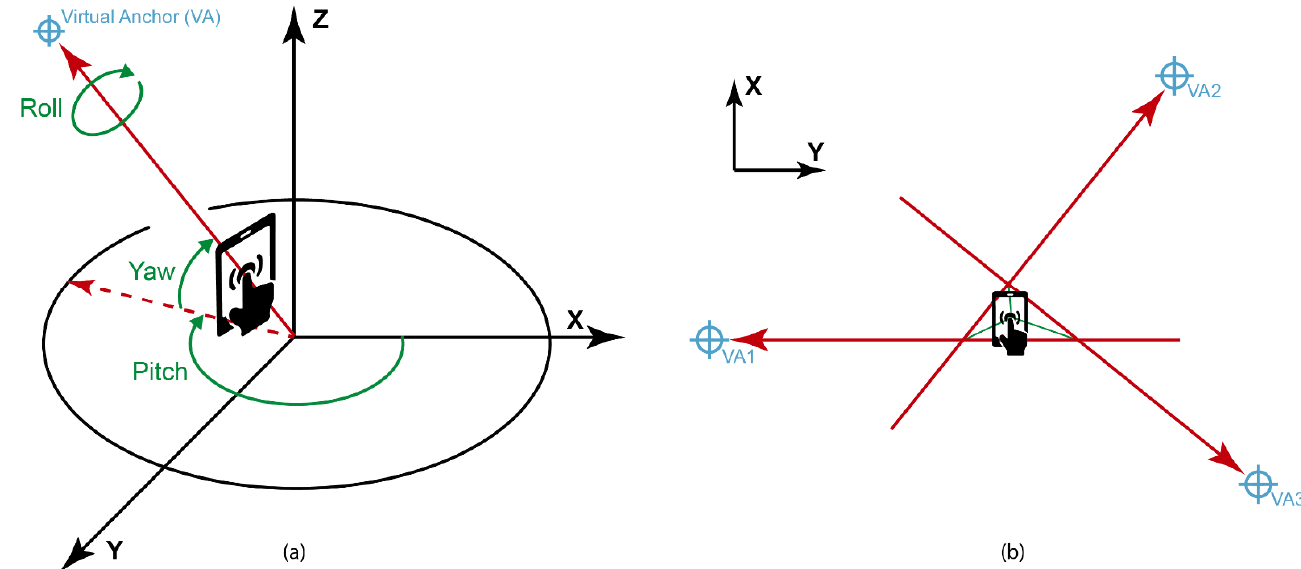
Figure 2. Isometric projection ( a ) and plant ( b ) of the calibration method for low ‐ specs device.